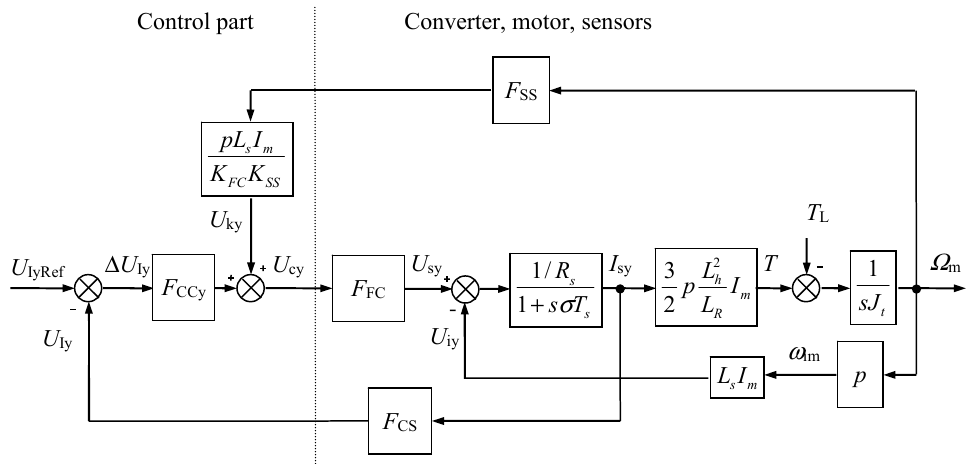
Figure 6. Torque-producing stator current control structure with decoupling block.